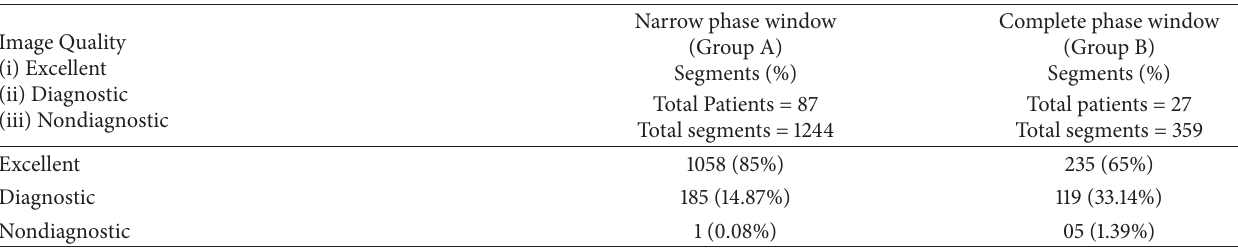
Table 3: Summary of image quality for two groups undergoing imaging using complete versus narrow phase window acquisition at 320-row